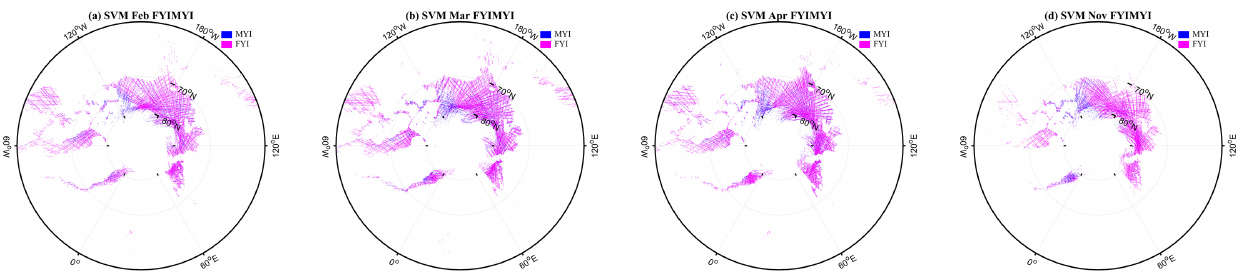
March, ( c ) April, and ( d ) December are used as the test set in turn.